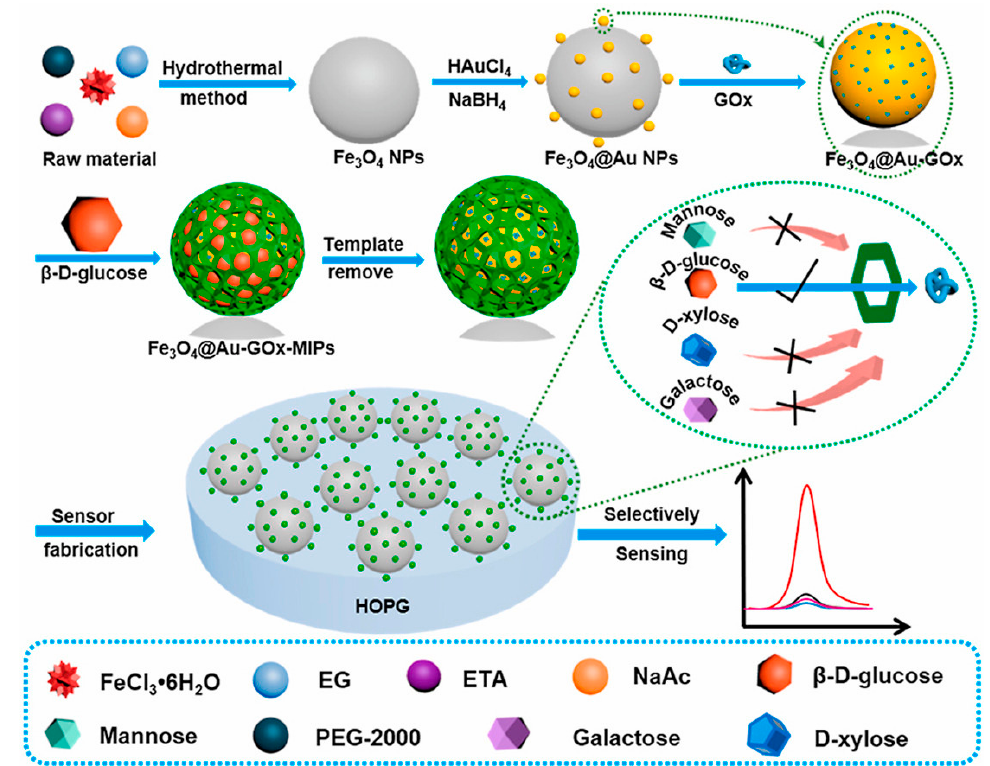
Figure 7. Preparation of the Fe 3 O 4 @Au-GOx-MIPS sensor and representation of the sensing mechanism achieved with CV analysis. Figure reproduced with permission from ref. [120]. Copyright 2022, Elsevier.